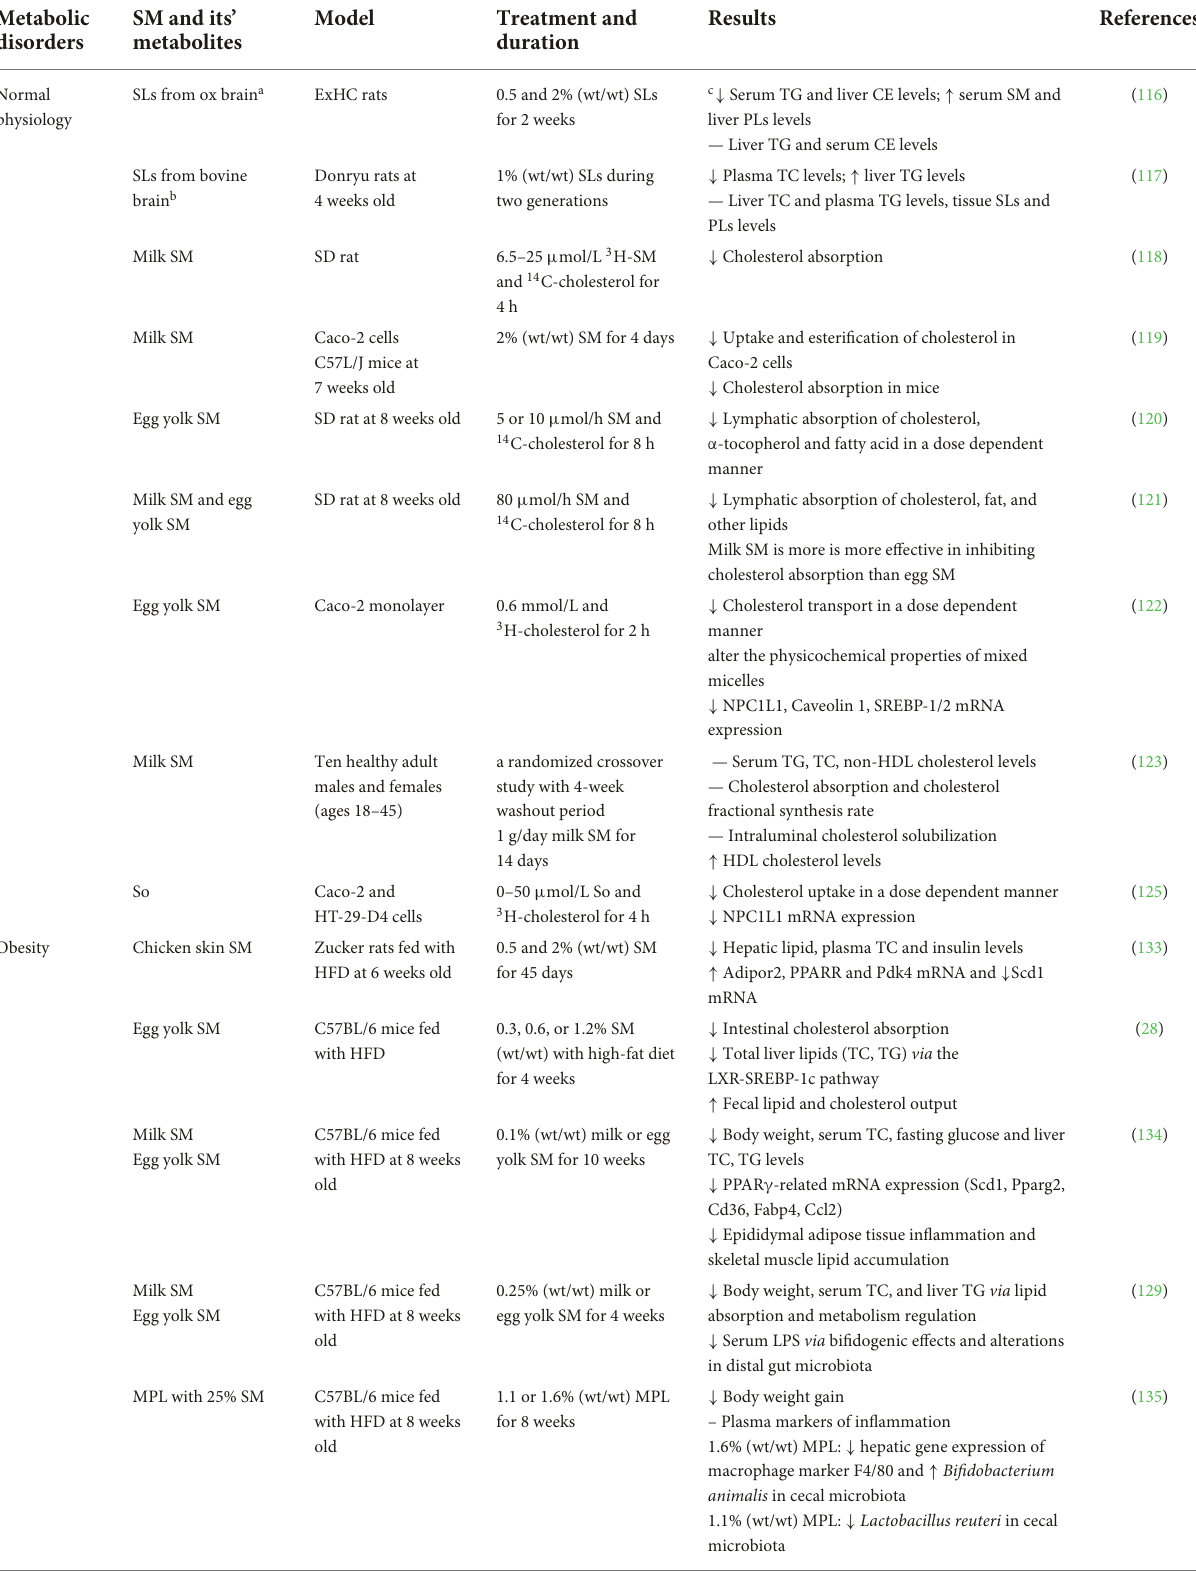
TABLE 3 Effects of dietary sphingomyelin and its metabolites on human physiology and chronic metabolic